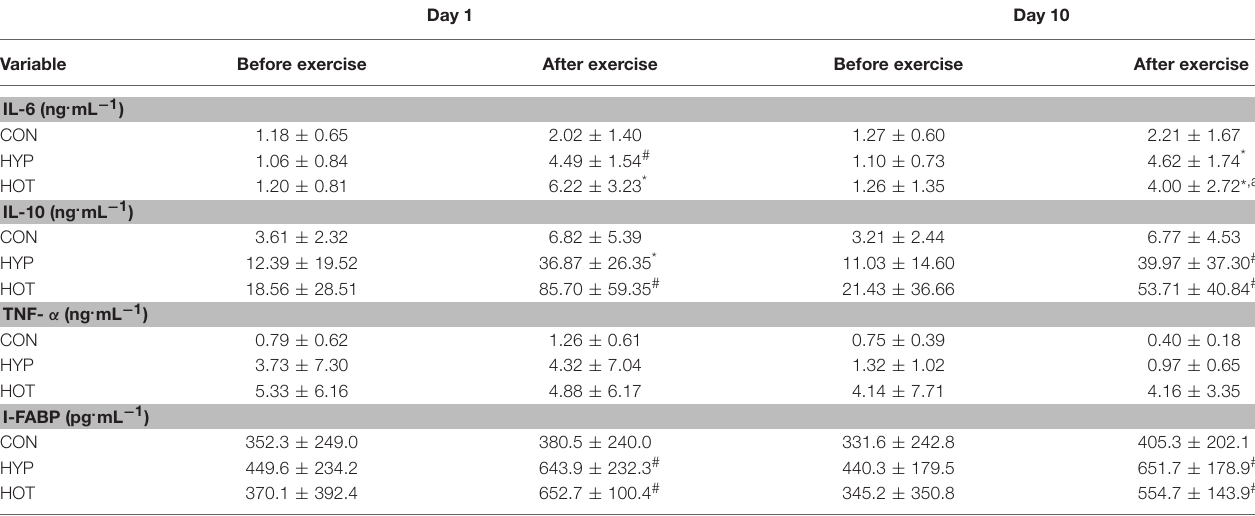
TABLE 2 | Mean ± SD differences before and after exercise for systemic cytokines and intestinal fatty acid binding protein on day 1 and day 10 of the acclimation period. Day 1 Day 10 Variable Before exercise After exercise Before